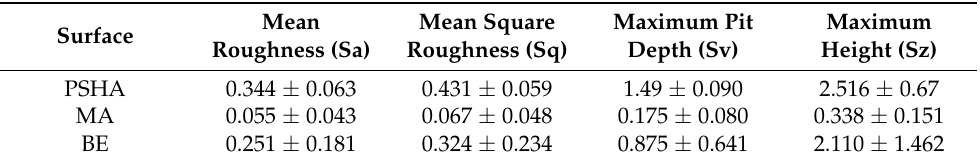
Table 1. Comparative analysis between the PSHA, MA and BE surfaces regarding mean roughness (Sa), mean square roughness (Sq), maximum pit depth (Sv), and maximum height (Sz). Mean Mean Square Maximum Pit Maximum Surface Roughness (Sa) Roughness (Sq) Depth (Sv) Height (Sz) PSHA